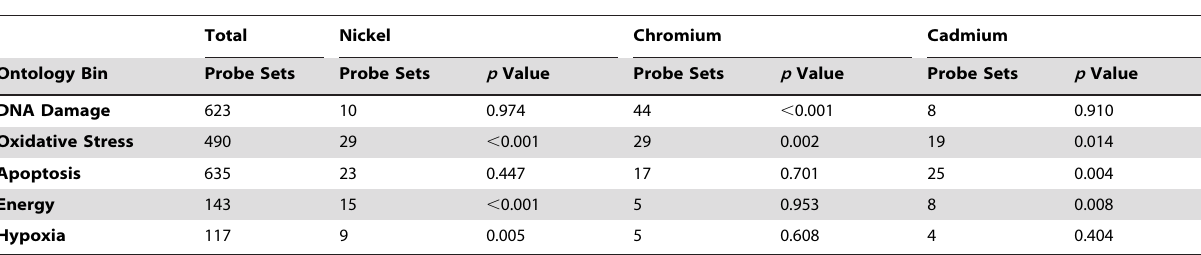
Table 1. Enriched ontology bins by metal.